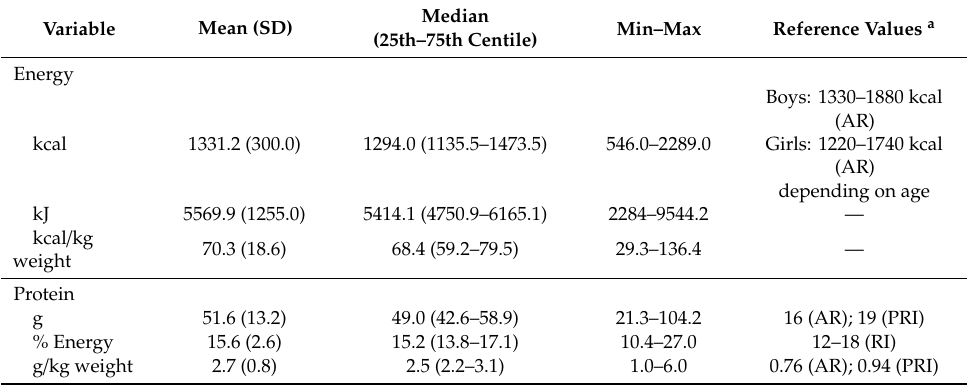
Table 5. Daily dietary intake of energy, macronutrients, and fiber, in children aged 4 ≤ years < 7 ( n =